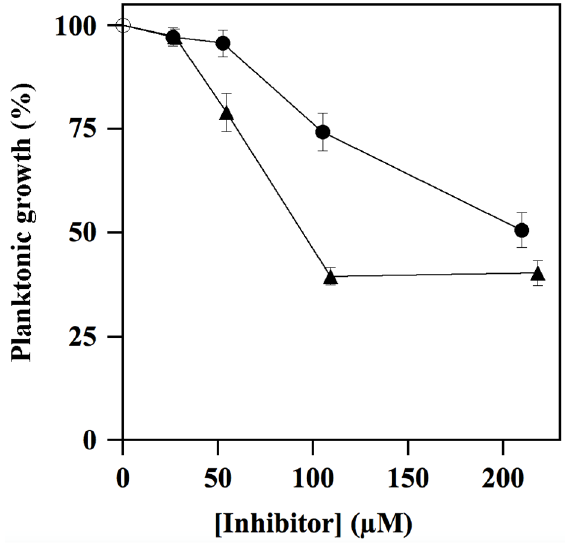
Figure 8. Effect of ALS-31 and ALS-31-9 on the planktonic growth of Streptococcus mutans cultures. The antimicrobial activity of S. mutans was investigated and evaluated, as indicated in Materials and Methods, in the absence ( ) or in the presence of the indicated concentration of ALS-31 ( ) or ALS-31-9 ( ).